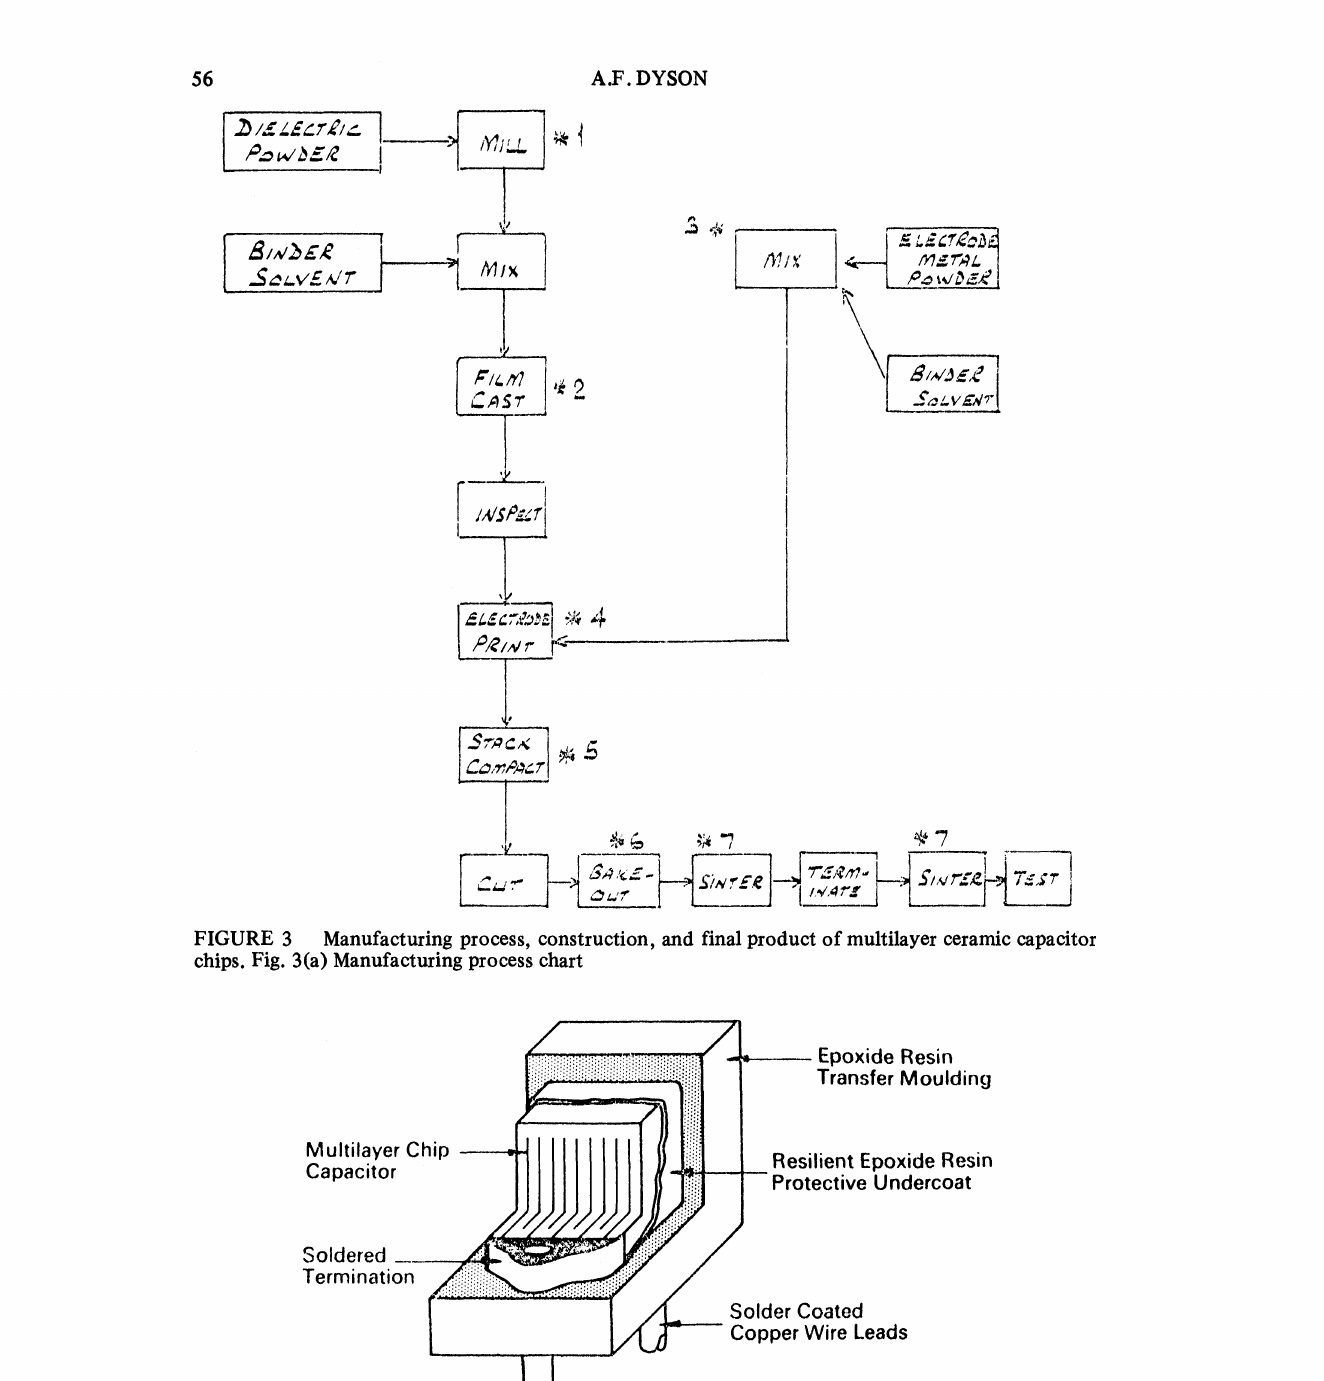
Epoxide Resin Transfer Moulding Resilient Epoxide Resin Protective